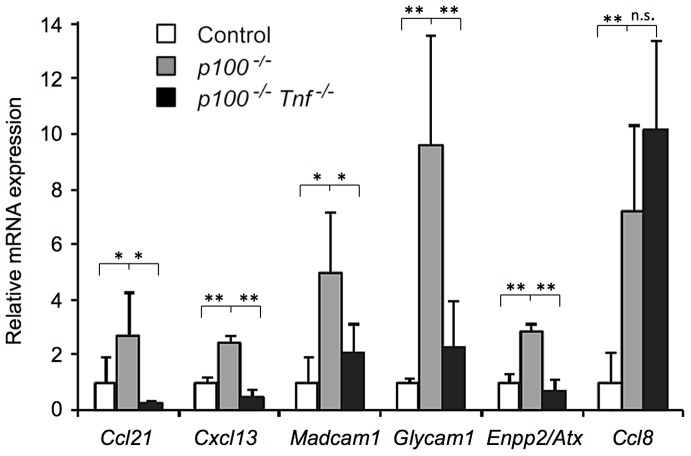
Synergistic regulation of gene expression by the classical (TNF) and the alternative (p100−/−) NF-κB pathway in vivo.Changes in mRNA levels of selected genes contributing to chemotaxis, lymphocyte homing, and cell adhesion were analyzed by qRT-PCR using RNA samples isolated from spleens of control (wild-type for the Nfkb2 locus and heterozygous for the TnfLta locus), p100−/− (deficient for the p100/Nfkb2 and wild-type for the TnfLta locus), and p100−/− Tnf−/− (deficient for both the p100/Nfkb2 and the TnfLta locus) animals. Four independent experiments were performed representing n = 6 control mice, n = 5 p100−/− mice, and n = 4 p100−/− Tnf−/− mice. Data are presented as mean values ± SD. Significant differences (P≤0.05) were calculated by Student's t-test and are indicated (*). * P≤0.05; ** P≤0.01; n.s. = not significant.